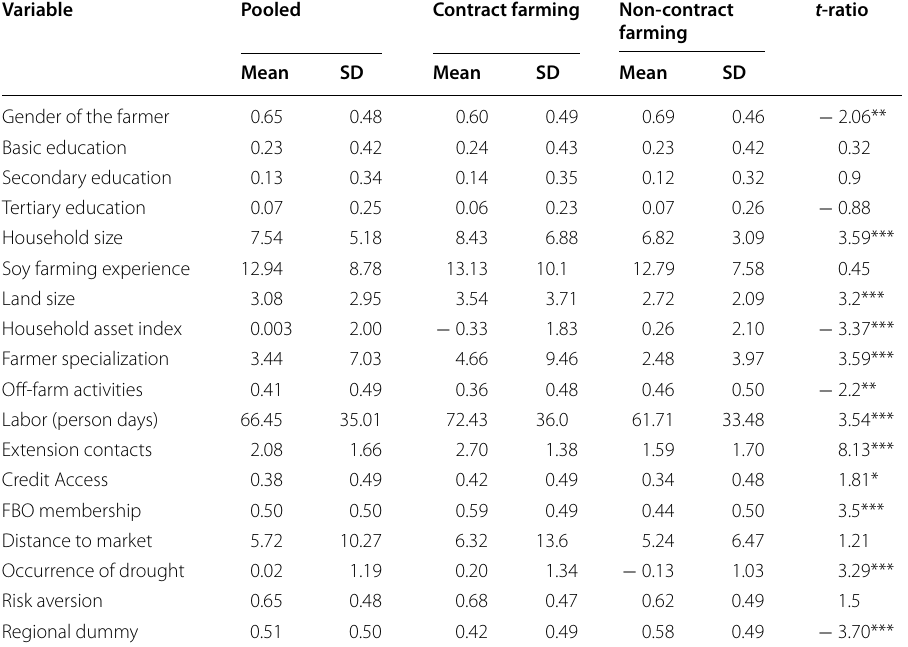
Table 2 Summary statistics